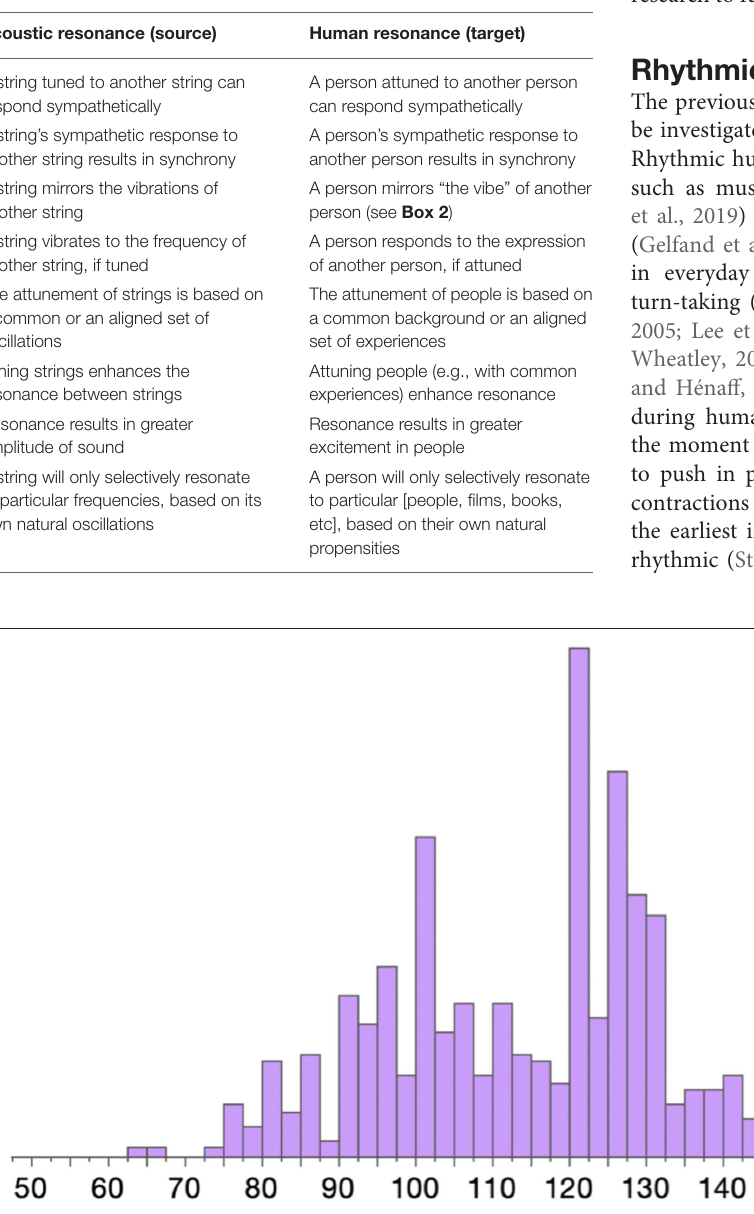
Frontiers in Neurorobotics |